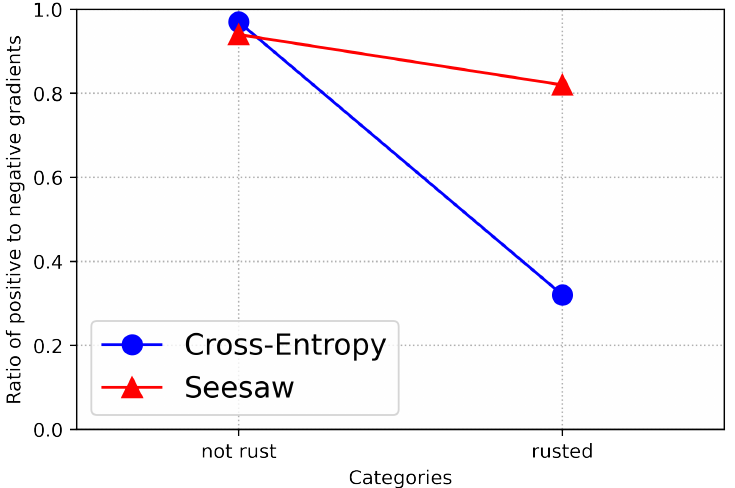
Figure 4. Under the traditional cross-entropy loss, the head class’s positive and negative sample gradients are close to 1.0 while the sparse tail class is tiny, which will cause an accuracy bottleneck. The seesaw loss is adjusted by reducing the negative sample gradient of the tail class to obtain a more balanced gradient